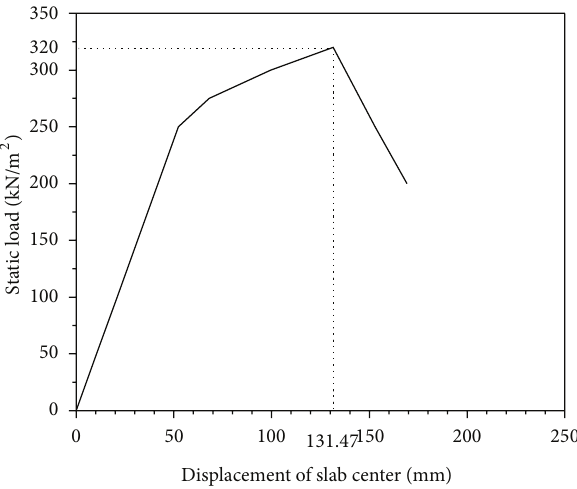
Figure 12: Displacement-static load curve of slab